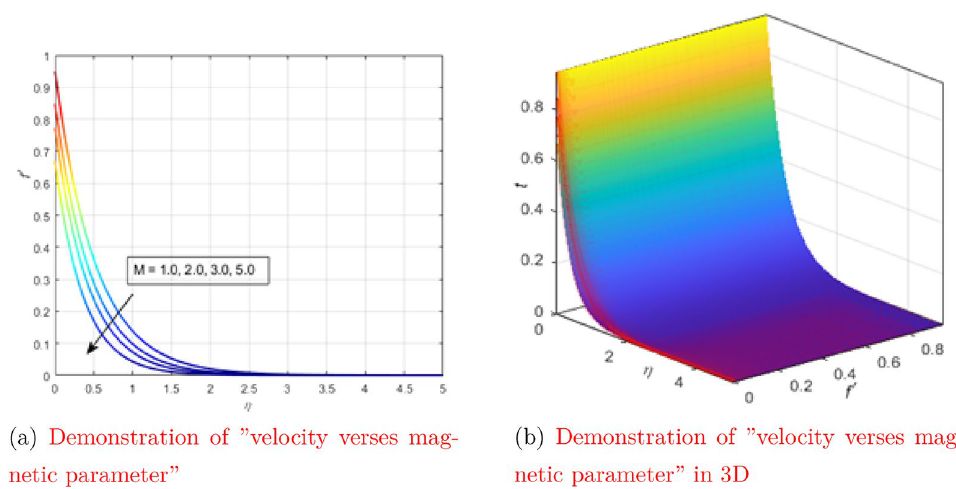
Figure 2. Demonstration of the dependence of velocity on the physical parameters in both 2D and 3D (see Appendix